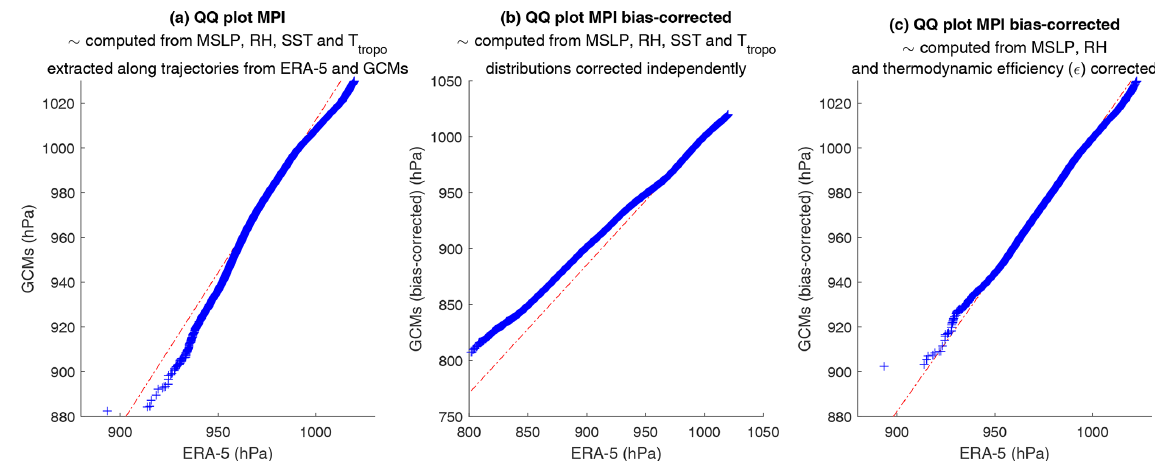
Figure 21. Bias-correction module Q–Q plots (GCMs vs. ERA5) of maximum potential intensity (hPa). The Q–Q plots compare two distri- butions by plotting quantiles of one against the other. Table 3. Correlation levels (global) of modeled variables affecting the MPI with their reference values in ERA5. SST ERA5 SST GCMs MSLP ERA5 MSLP GCMs T tropo SST ERA5 1 SST GCMs 0.95 1 MSLP ERA5 0.46 0.39 1 MSLP GCMs 0.45 0.38 0.86 − 0.77 − 0.79 RH ERA5 − 0.07 − 0.07 − 0.12 − 0.09 0.22 0.19 RH GCMs − 0.27 − 0.30 −